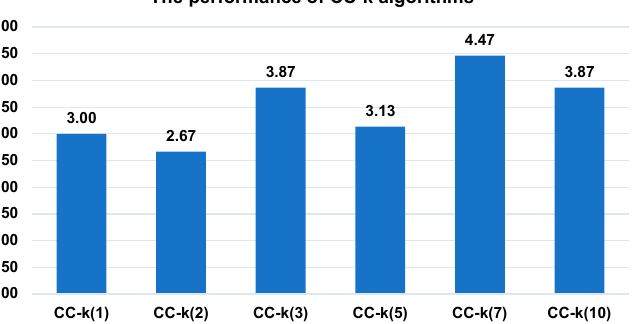
Figure 3. The ranking of CC-k algorithms.